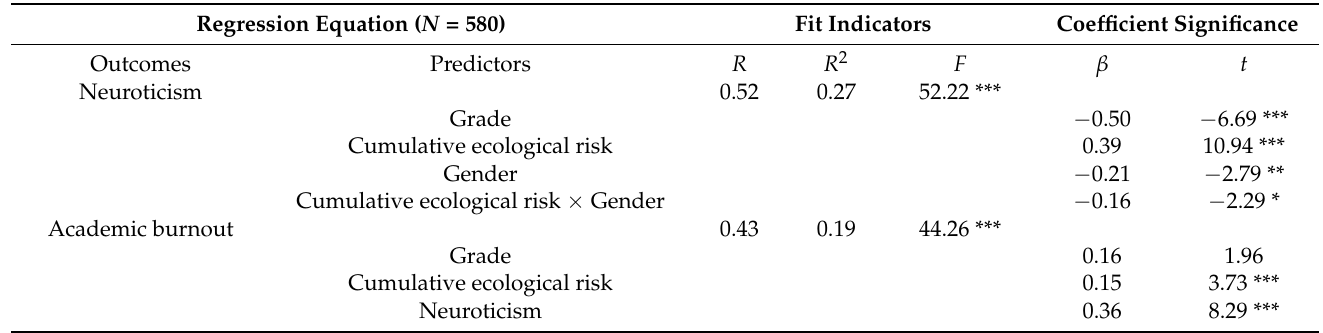
Table 3. Testing the moderated mediation effect of cumulative ecological risk on academic burnout. Regression Equation ( N =